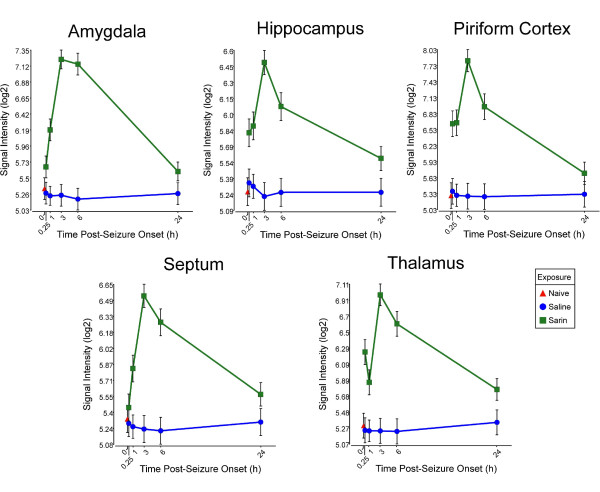
Sarin-induced seizure up-regulates the expression of TNF-α in all five brain regions examined. Brain tissues were collected at 0.25, 1, 3, 6, and 24 h after seizure onset and processed for oligonucleotide microarray analysis. TNF-α expression was induced as early as 0.25 h following seizure onset, peaked at 3 h, and returned to near control levels by 24 h after seizure onset.